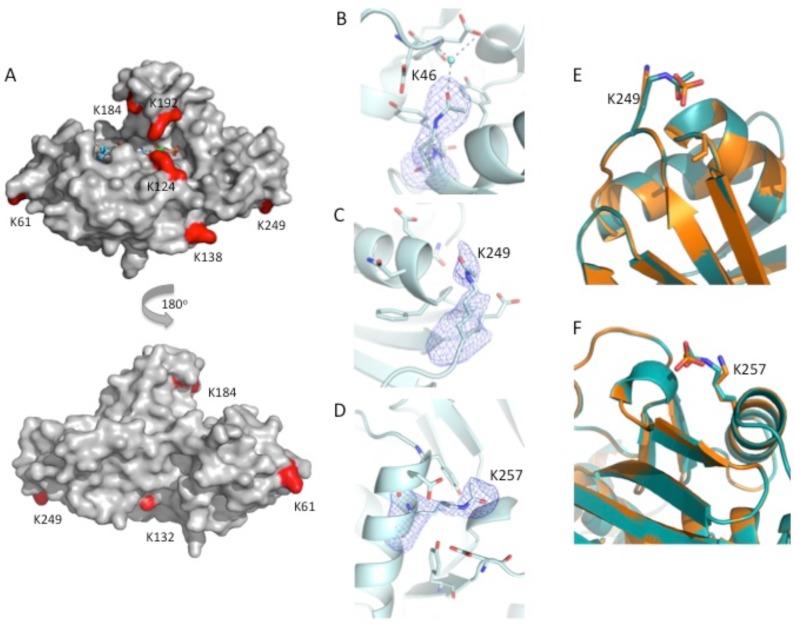
Crystal structure of glyceraldehyde-3-phosphate dehydrogenase (GapA) from E. coli in native (PDB ID: 1S7C) and acP-modified (PDB ID: 4MVJ) forms.
A) Surface representation of GapA with the locations highlighted in red of up-regulated acetylated lysine residues in the ackA mutant as determined by mass spectrometry. Front and back views of the protein are shown and NAD+ (shown with sticks) is bound at the active site pocket. B) Electron density map surrounding acetylated K46 in the GapA crystal structure. The Fo-Fc omit map in blue mesh is contoured at the 3 sigma level. Residues are shown as sticks and water is represented as a sphere. C) Electron density map surrounding acetylated K249 in the GapA structure. The Fo-Fc omit map in blue mesh is contoured at the 2 sigma level. D) Electron density map surrounding acetylated K257 in the GapA structure. The Fo-Fc omit map in blue mesh is contoured at the 2 sigma level. Oxygens, nitrogens, and carbons are shown in red, blue and light blue, respectively. E, F) Overlay of the K249 and K257 residue of GapA (PDB ID: 4MVJ) in its acetylated and non-acetylated form, respectively. Phosphate is present in the non-acetylated form and binds in the same location as the acetyl group of the acetylated residue. The protein with the non-acetylated lysine and phosphate bound is shown in orange, the protein with the acetylated lysine is in teal, oxygen atoms are in red and nitrogens are in blue.